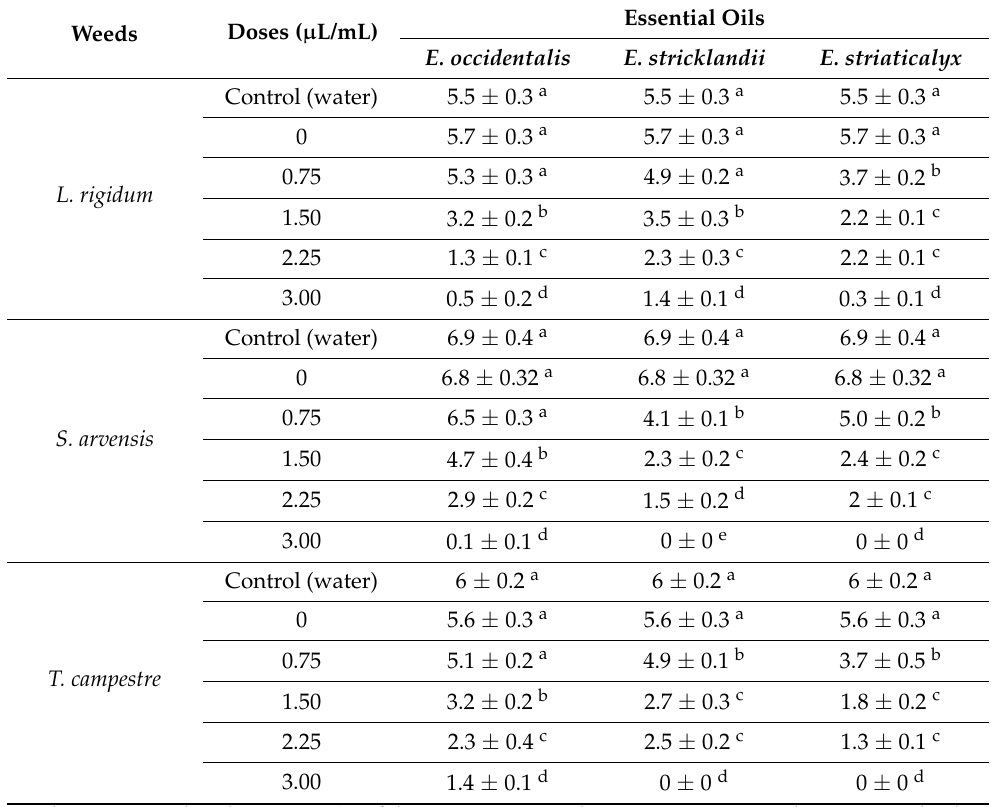
Table 4. Inhibitory effect of the EOs on root growth (cm) of Lolium rigidum , Sinapis arvensis and Trifolium campestre .